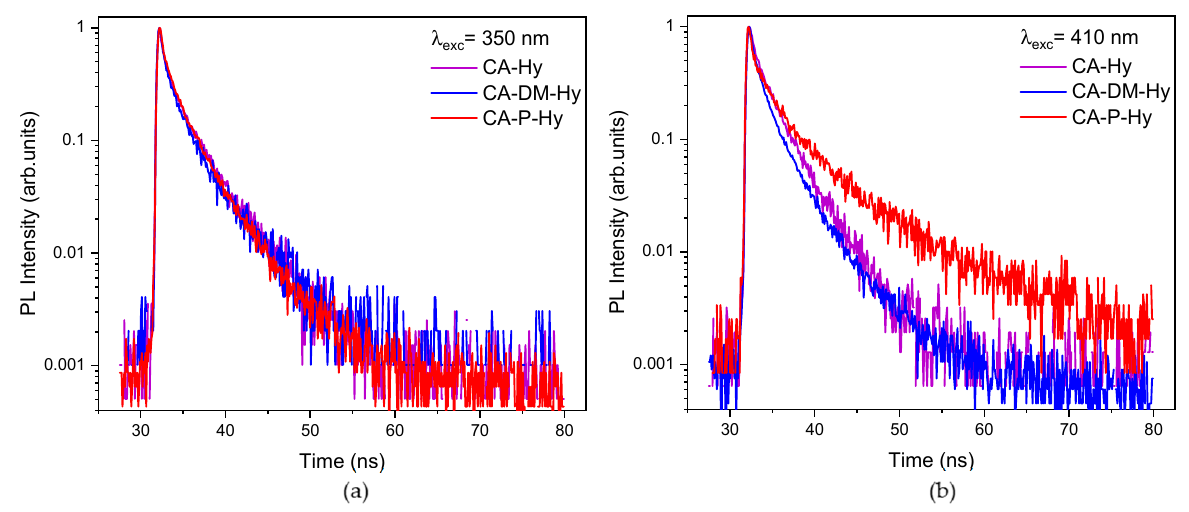
Figure 4. TR-PL decays of a sample excited at 350 nm ( a ) and 410 nm ( b ).